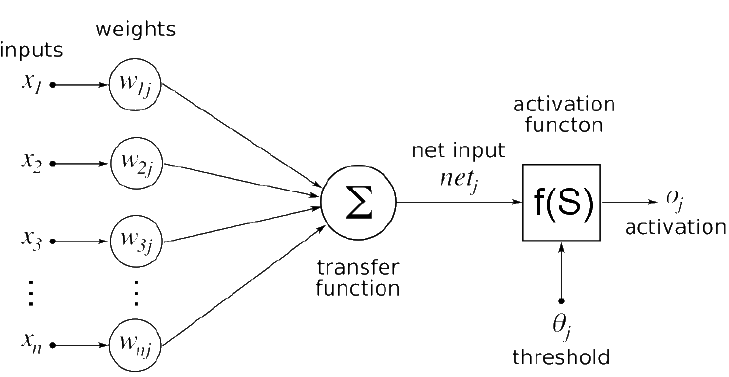
Figure 4. Mechanism of artificial neuron depicting biological neuron